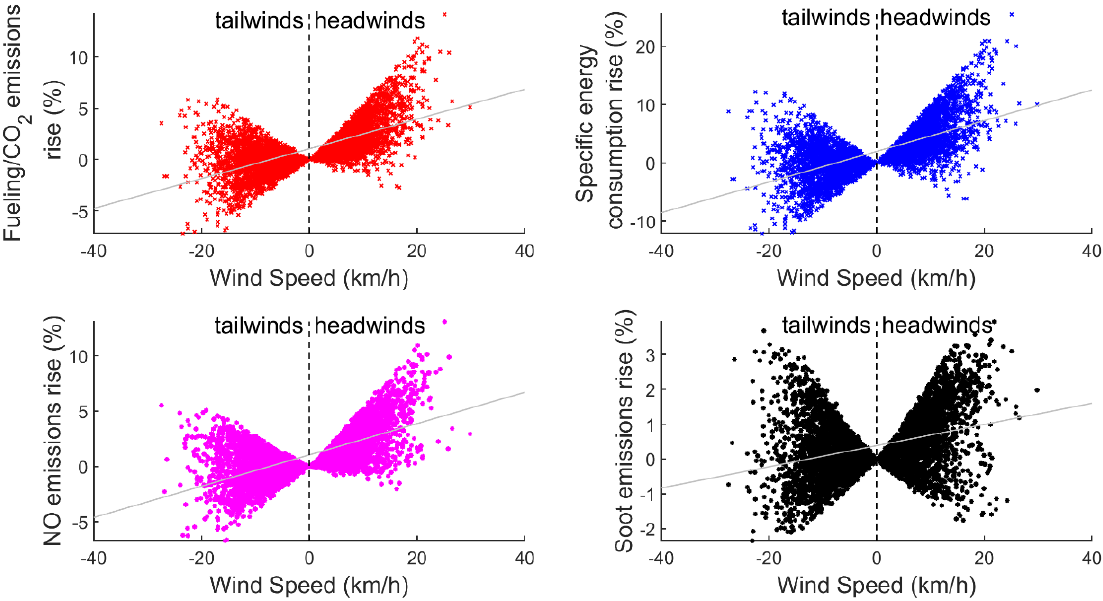
Figure 8. Percentage increase in consumption and emissions vs. wind speed for the high phase of the WLTC.